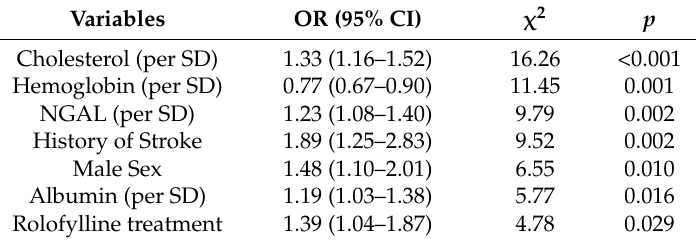
Table 3. Multivariable logistic regression for prediction of worsening renal